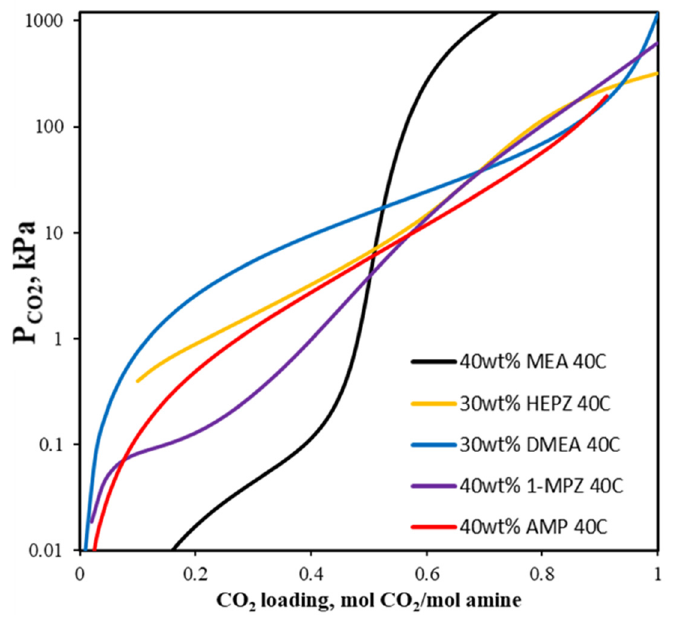
Figure 6. The CO 2 solubility curve of various solvents at 313.15 K.